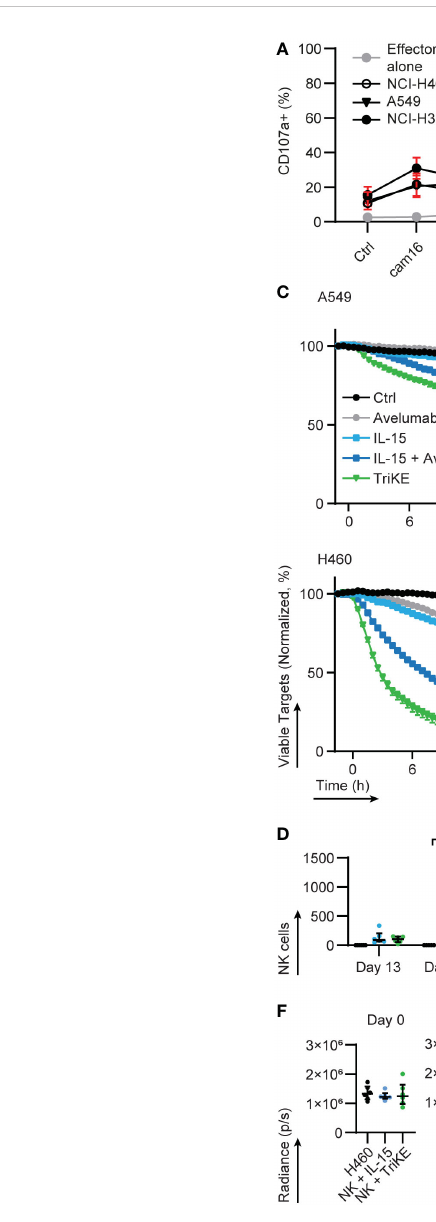
FIGURE 5 Cam1615SS1 enhances cytokine production, cytolysis and in vivo activation of NK cells. (A) PBMC were cultured in the presence of the indicated drugs (30nM) for 5 hours alone or in contact with lung cancer lines: NCI-H322, NCI-H460, A549. The amount of (A) degranulation (CD107a+) and (B) cytokine secretion (IFN g ) by NK cells (CD56+ CD3-) was assessed by fl ow cytometry. Effectors alone (Ctrl, IL-15, TriKE n=20; cam16 n=17; SS1 n=13), NCI-H322 (Ctrl, IL-15, TriKE n=14; cam16 n=11; SS1 n=10), NCI-H460 (Ctrl, IL-15, TriKE n=12; cam16 n=9; SS1 n=8), A549 (Ctrl, IL-15, TriKE, cam16, SS1 n=8). Bars show median and interquartile range. Analyzed by Kruskal-Wallis test with Dunn ’ s multiple comparisons. Signi fi cant differences are indicated by * p<0.05, ** p<0.01, **** p<0.0001 when comparing the effector alone with TriKE to the respective tumor condition with TriKE. (C) 10,000 fl uorescent (NuclightRed) A549 (top row) or NCI-H460 (bottom row) were plated in triplicate with a fl uorescent indicator of apoptosis (caspase 3/7 green) and allowed to adhere overnight. At time zero, puri fi ed NK cells were added to the wells at the speci fi ed effector to target cell ratios (E:T) with the indicated drugs (30nM TriKE; 0.67nM ‘ equifunctional ’ IL-15; 10 m g/mL Avelumab). Cancer cell survival, normalized to the growth of cancer cells in wells without NK cells, was calculated on the basis of fl uorescent cells that were not caspase 3/7+. One representative donor of at least three is shown. Bars show the mean and standard error of the mean for triplicates. (D – F) A metastatic xenogeneic model of lung cancer was established in NSG mice by intravenous injection of GFP/luciferase-expressing NCI-H460 cells. Three days after engraftment ( ‘ day 1 ’ ), control mice were left untouched (black symbols), but test groups received 1 million human NK cells injected intravenously and treated with IL-15 treatment (blue symbols) or TriKE (green symbols). (D) The number of NK cells in blood samples drawn at two different timepoints was quanti fi ed by fl ow cytometry (mouse CD45-, human CD45+, human CD56+, human CD3-). (E) The proportion of these human NK cells with detectable surface CD69 was quanti fi ed by fl ow cytometry. (F) Tumor growth two days after engraftment ( ‘ day 0 ’ ) and 6 days after NK cell dosing ( ‘ day 7 ’ ) were quanti fi ed by bioluminescent imaging. Each dot represents an animal. Bars show the median and interquartile range. NK cell numbers and CD69 proportions were assessed by two-way ANOVA with Sidak ’ s multiple comparison test. Bioluminescent values for IL-15 and TriKE treatment were compared at day 0 and day 7 with a Mann-Whitney test. * p<0.05,